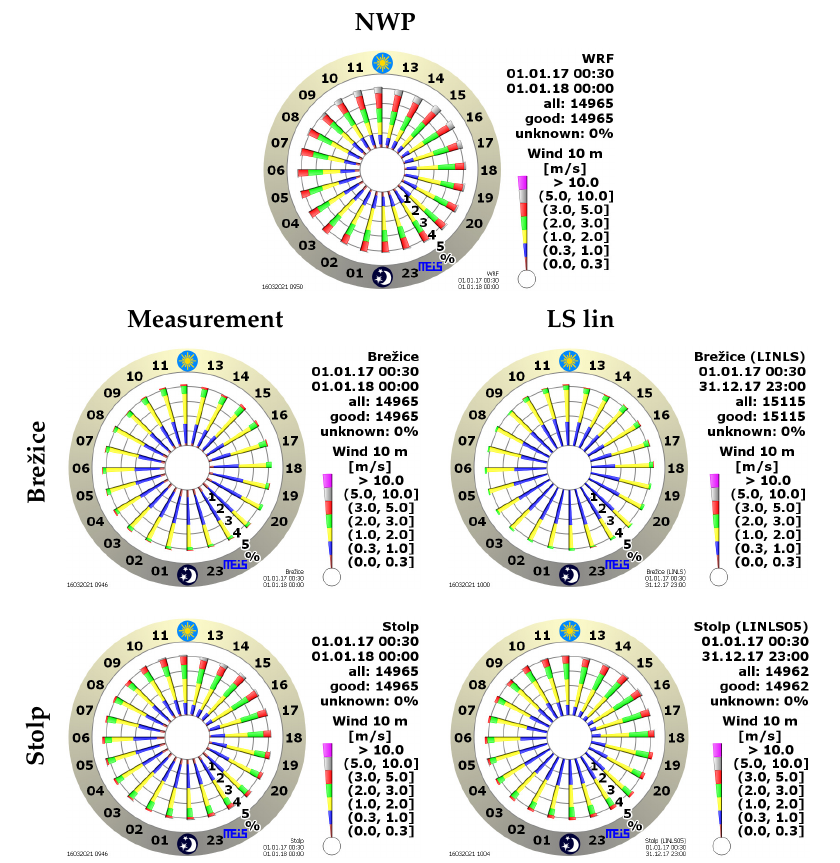
Figure 10. Sunflower diagrams [39] for Brežice and Stolp meteorological stations. The measurements ( left ) are compared to the linear regression with least squares model trained on one month of data ( right ) and the NWP model ( top ). The experimental models used are the same as in Figures 8 and 9, the LS lin model predictions are for the test data. In a sunflower diagram, each one of the 24 sectors corresponds to one hour of the day. The values for each hour are sorted into classes that are represented with sections of different colours. The length of each section is proportional to the statistical frequency of the values within the